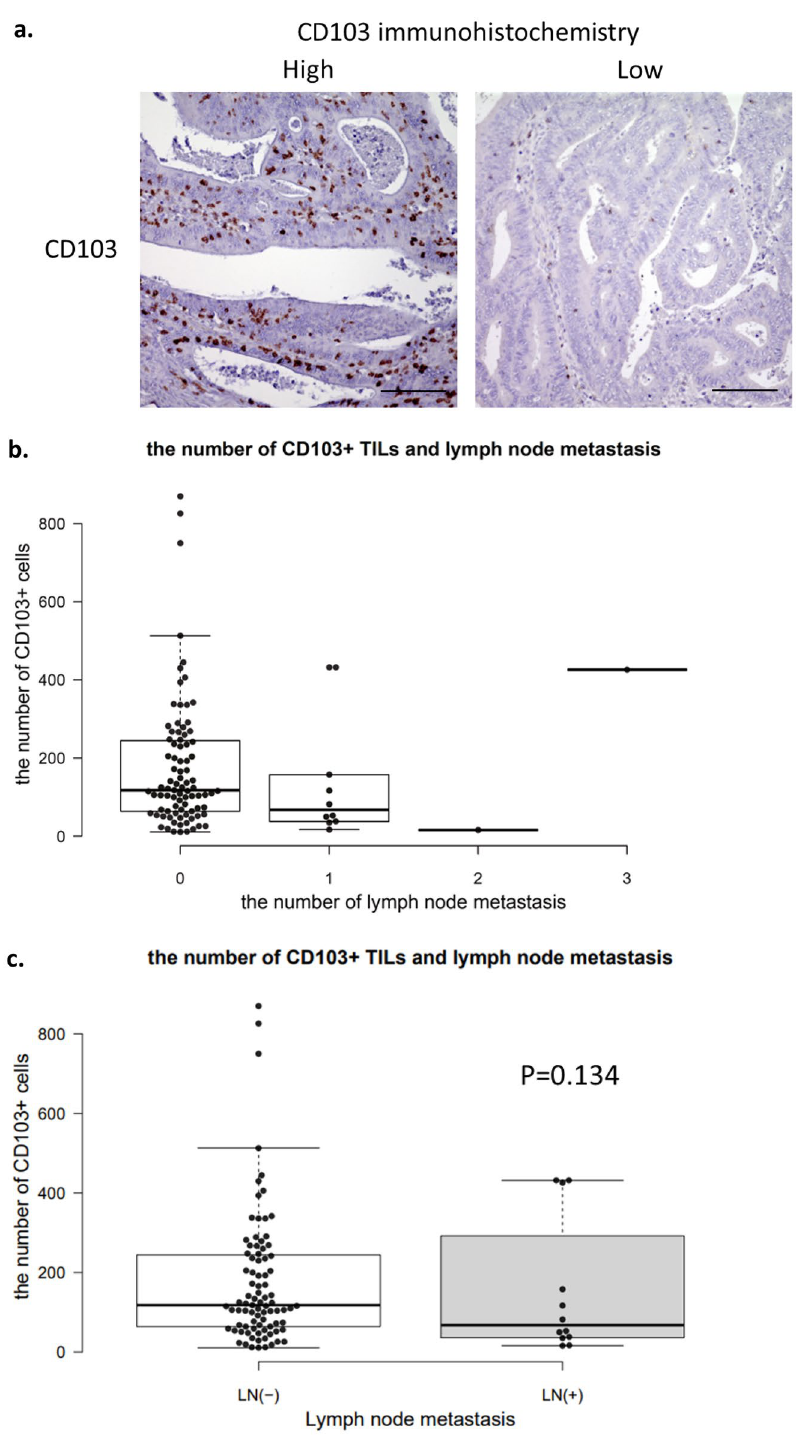
Figure 5. ( a ) Immunohistochemical staining for CD103 TILs at invasive margins of resected CRC tissue (left: high invasion; right: low invasion). ( b ) The number of CD103 + TILs and presence of lymph node metastasis from SM-CRC ( P = 0.134). ( c ) The number of CD103 + TILs and lymph node metastases from